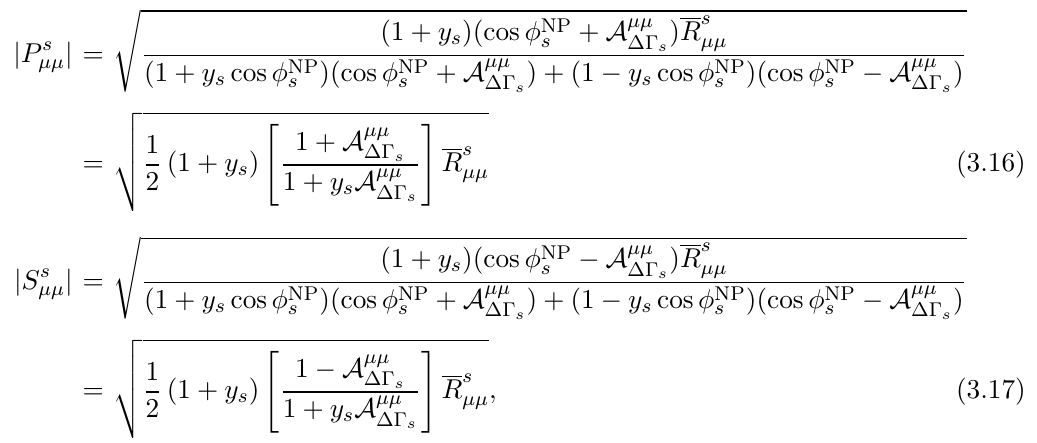
(cid:22)(cid:22) and thus , (cid:22)(cid:22) (cid:1)(cid:0) s A and S s up to discrete (cid:22)(cid:22)